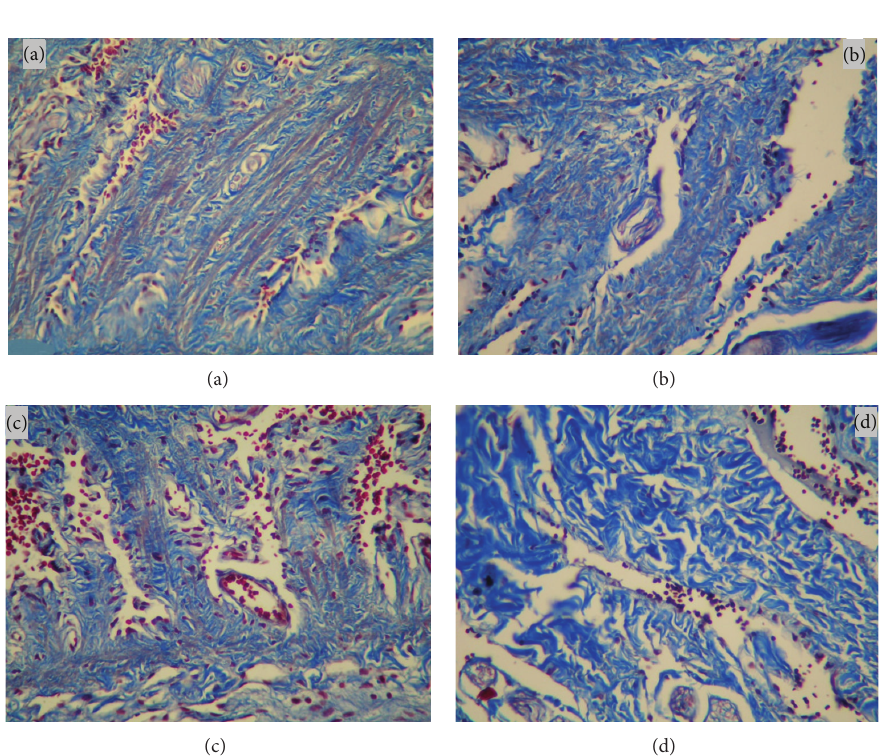
Figure 1: Histological view of collagen density in the cavernosal tissues stained with Masson’s trichrome ( × 400).